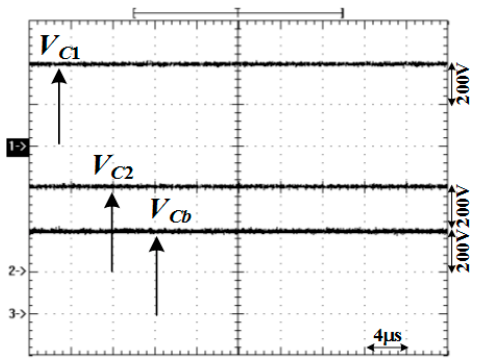
Figure 8. Measured input-side capacitor voltages at 100% load and 800 V input.